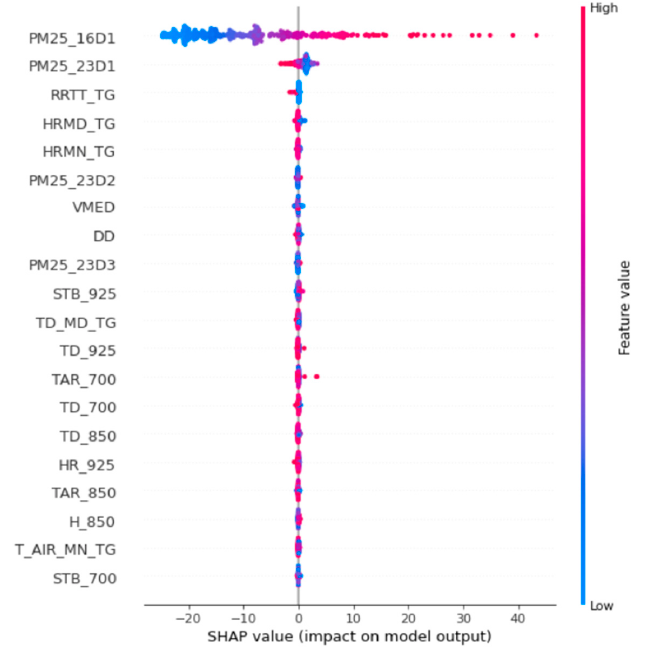
Figure 3. Feature ranking using the SHAP values for the RF model trained using 2013–2018 data and tested using 2019 data which predicts PM 2.5 with SHAP values in 2013 to 2018 trained data and 2019 test data.